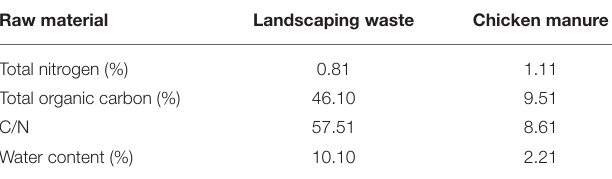
TABLE 3 | Basic physicochemical properties of main composting materials. Raw material